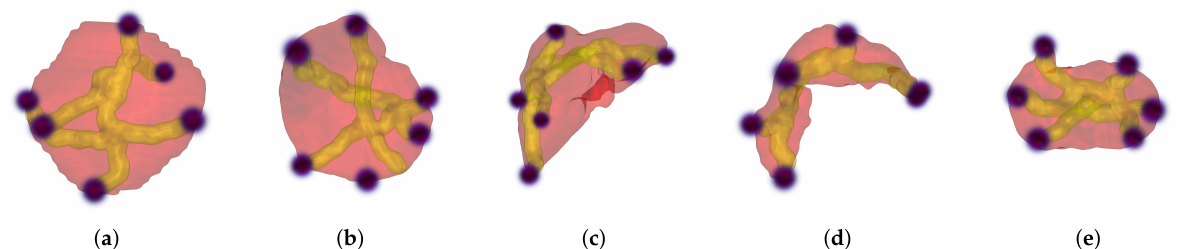
Figure 2. Examples of automatically created foreground “scribbles” (yellow) from extreme point clicks, modeled as 3D Gaussians in our network learning. We use a geodesic shortest path algorithm to compute a scribble based on the image information alone that connects two opposing extreme points across one of the three image dimensions. ( a – e ) are showing examples from MSD-Spleen , MO-Spleen , MO-Liver , MO-Pancreas , MO-L.Kidney , and MO-Gallbladder , respectively. The surface rendering show the ground truth segmentations for reference in red. Best viewed in